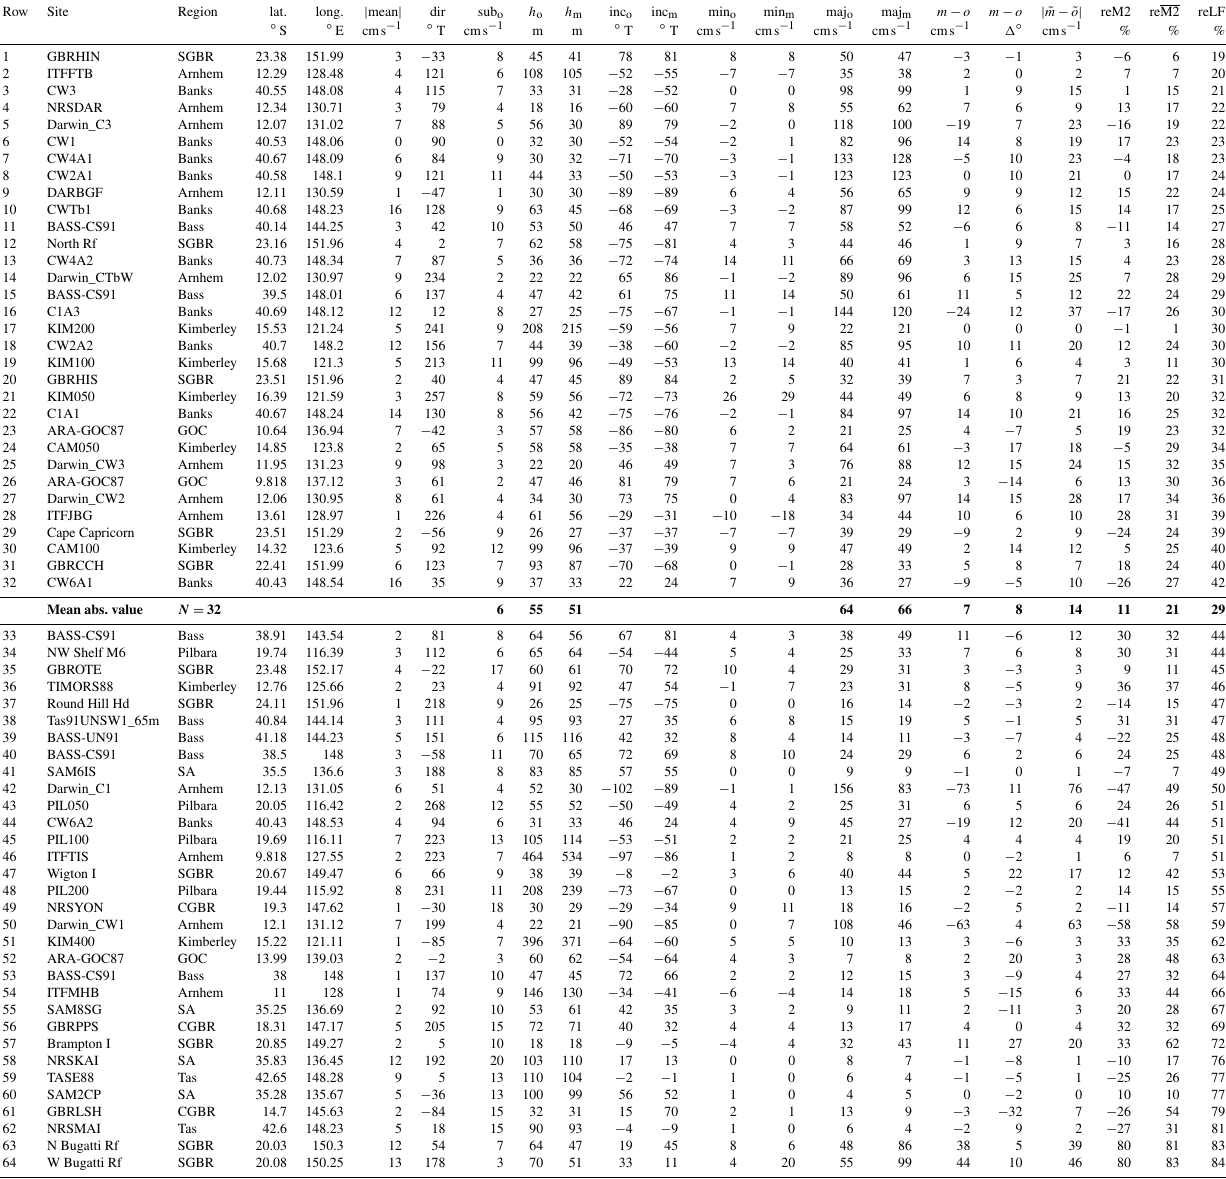
Table 3. Model errors at current meter sites – M2 constituent. The columns are current meter site name and location, then three measures of the observed, depth-averaged, non-tidal velocity: | mean | , dir, and sub o , which are the magnitude and (compass) direction of the mean and the magnitude of the root mean square of the sub-tidal low-pass-filtered velocity. Next are the observed (_o) and model (_m) values of depth h , M2 major axis inclination (inc), and minor and major axis amplitudes (min and maj). Next are the errors maj m − maj o and g m − g o ( m − o for short) of the major axis amplitude and Greenwich phase g , then the magnitude of the vector (amplitude and phase) error | ˜ m − ˜ o | . Next are three types of M2 percentage relative errors: reM2 = (m − o)/o , reM2 = | ˜ m − ˜ o | /o , and reLF = ( | ˜ m − ˜ o |+ sub o )/(o + sub o ). Sites are listed by ascending reLF. The means (over successive thirds of the dataset (e.g. after row 32), and then for all of it) of the absolute value of some quantities are given. Note that observed inclination angles are chosen to be − 90 to 90 ◦ T. Listed model inclinations and Greenwich phases are both flipped 180 ◦ in a few sensible